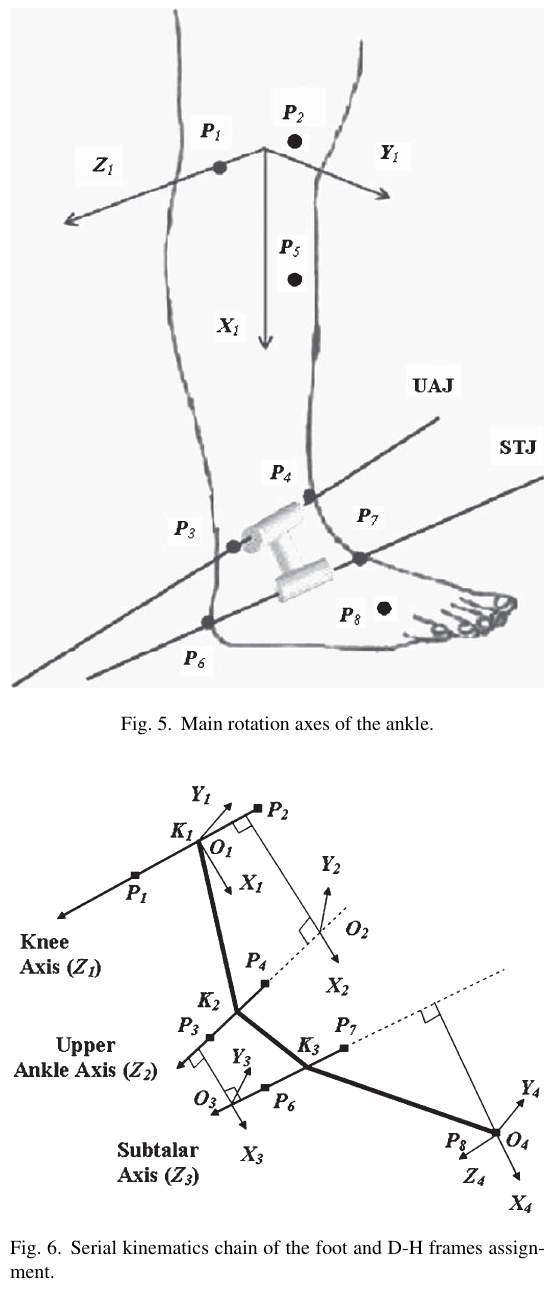
Fig. 6. Serial kinematics chain of the foot and D-H frames assign-